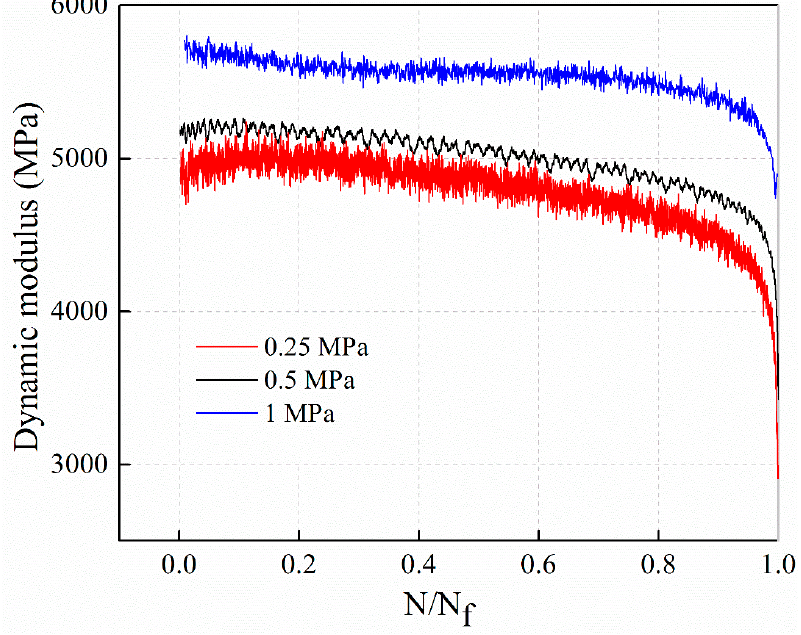
Figure 5. Decay law of dynamic modulus at different stress levels.